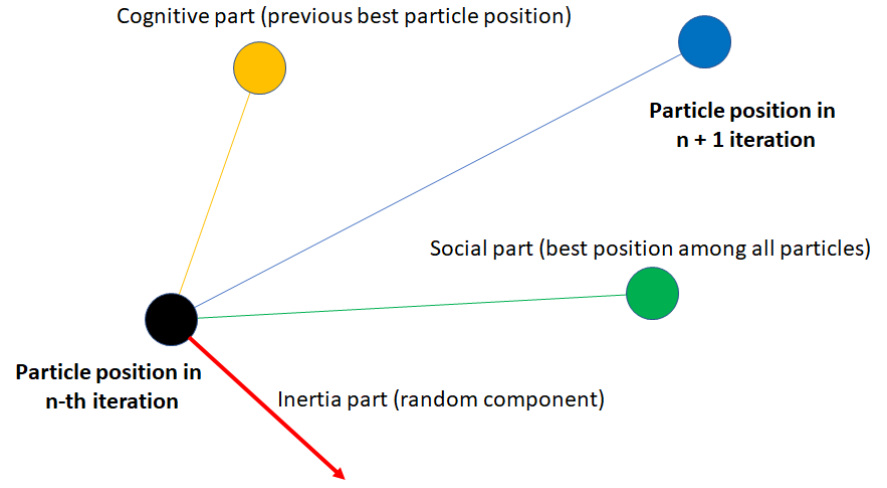
Figure 3. Particle moving in the PSO algorithm based on the inertia, social, and cognitive